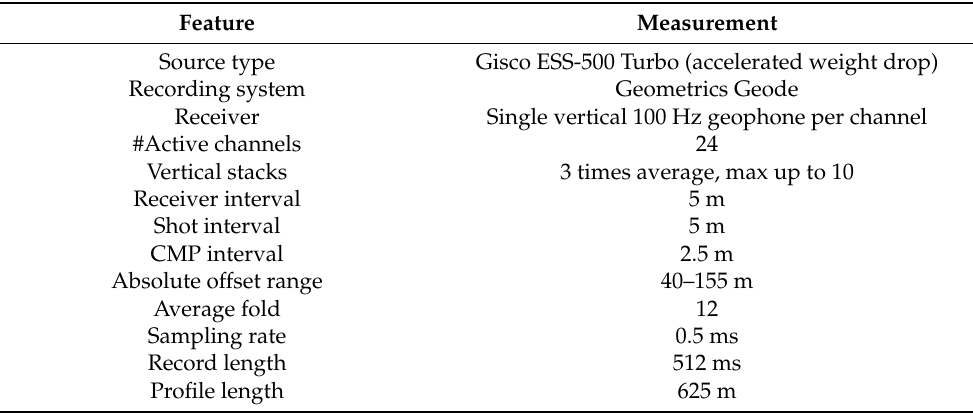
Table 1. Seismic acquisition